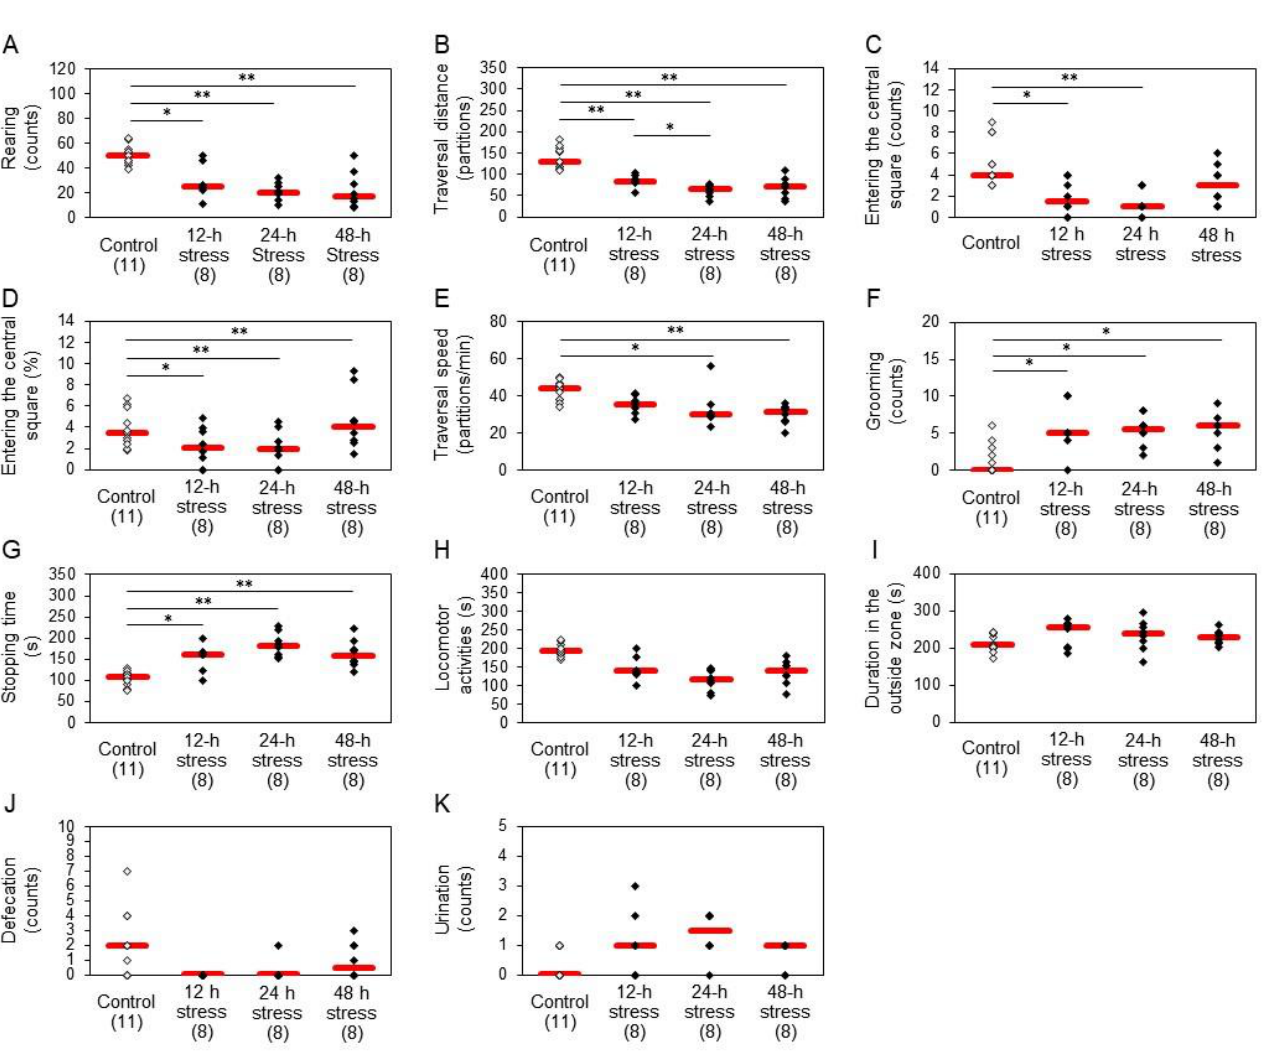
Figure 2. Effects of water immersion stress on rat behavior in the open field test. ( A ) Rearing; ( B ) traversal distance, ( C ) entering the central square (counts); ( D ) entering the central square (%); ( E ) traversal speed; ( F ) grooming; ( G ) stopping time; ( H ) locomotor activities; ( I ) duration in the outside zone; ( J ) defecation; ( K ) urination. Red bars represent the median. Parenthesis: the number of ani- mals. * p < 0.05, ** p < 0.01 by Steel − Dwass test. Stress caused anxiety-like symptoms, such as signif- icant decreases in rearing, travel distance, entering the central square, and travel speed, although